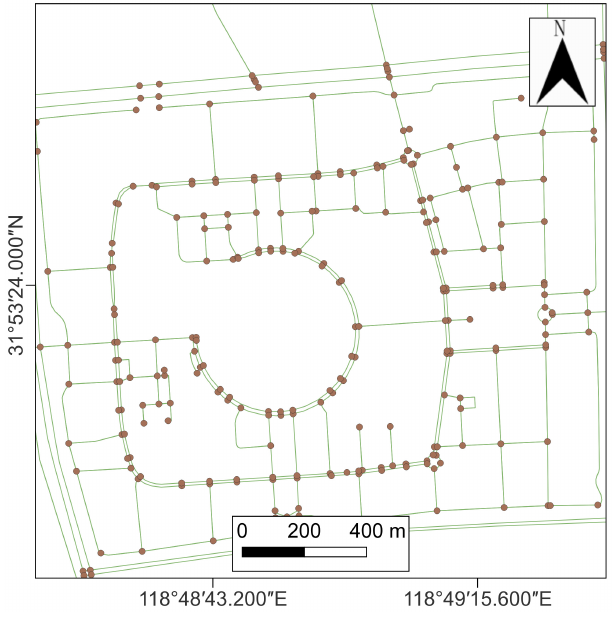
Figure 2. OSM road network.